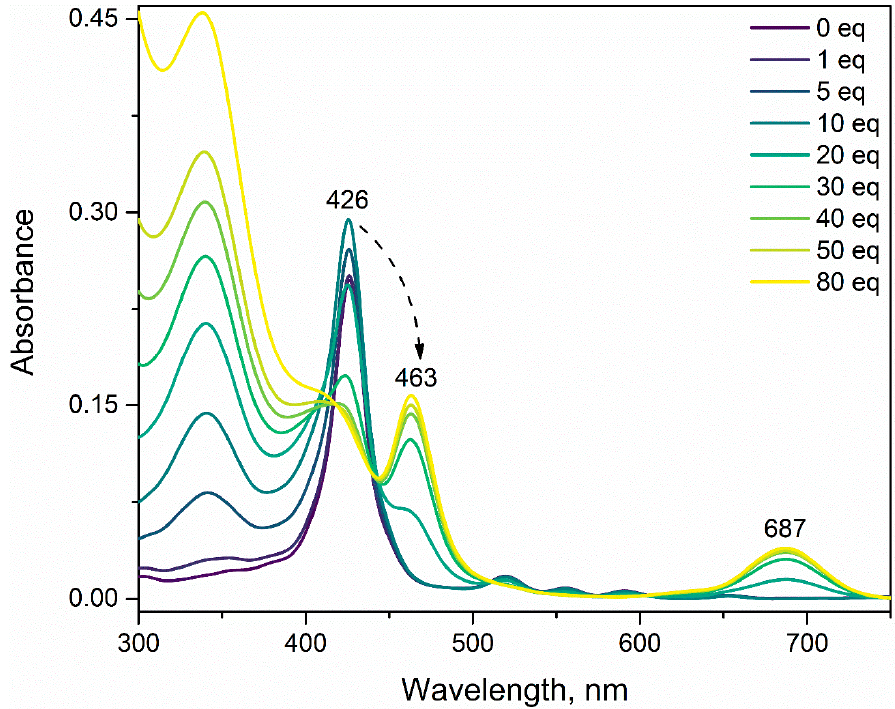
Figure 5. The UV-vis titration of H 2 PIP (9.2 × 10 − 7 M) with TNP (0–80 eq) in toluene. The arrow shows the shift of the Soret band upon titration.